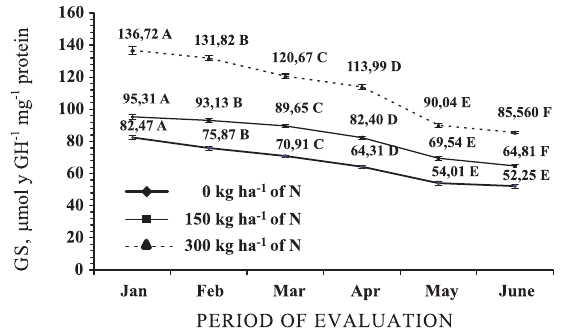
Figure 6. Leaf total soluble protein concentration during the fruit development stadium, considering different N-rates (control, 150 and 300 kg ha -1 ). Means followed by the same letter